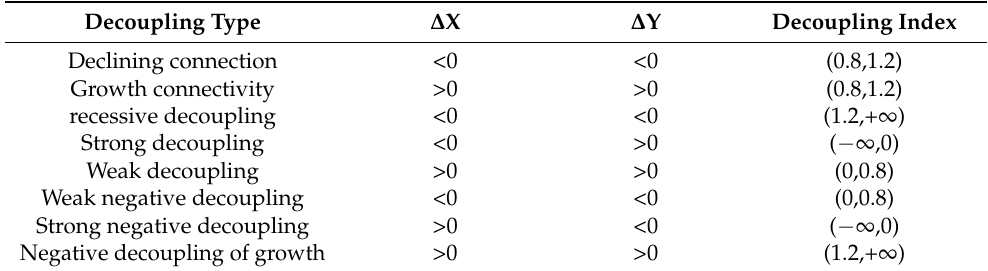
Table 3. Index and types of decoupling elasticity between Tapio urban economy and ecological